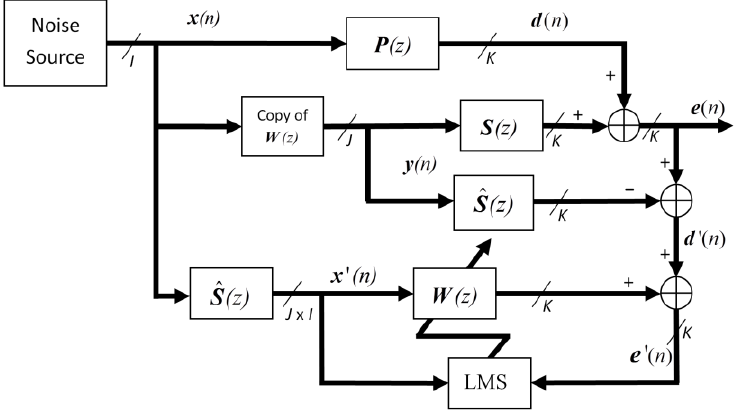
Figure 1. Block diagram of multichannel delay-compensated filtered-x least mean square (FXLMS) algorithm.